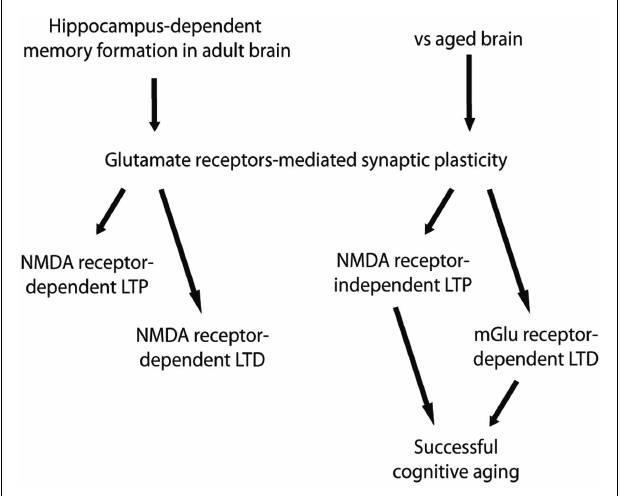
FIGURE 1 | Memory formation and synaptic plasticity in adult versus aged rat brain. Young and adult rats strengthen or weakened their neuronal networks interconnections using various adaptative mechanisms including NMDA receptor-dependent long-term potentiation (LTP) and long-term depression (LTD). On the other hand, successful cognitive aging has been associated with NMDA-independent LTP and mGluR-dependent LTD in memory-unimpaired Long-Evans aged